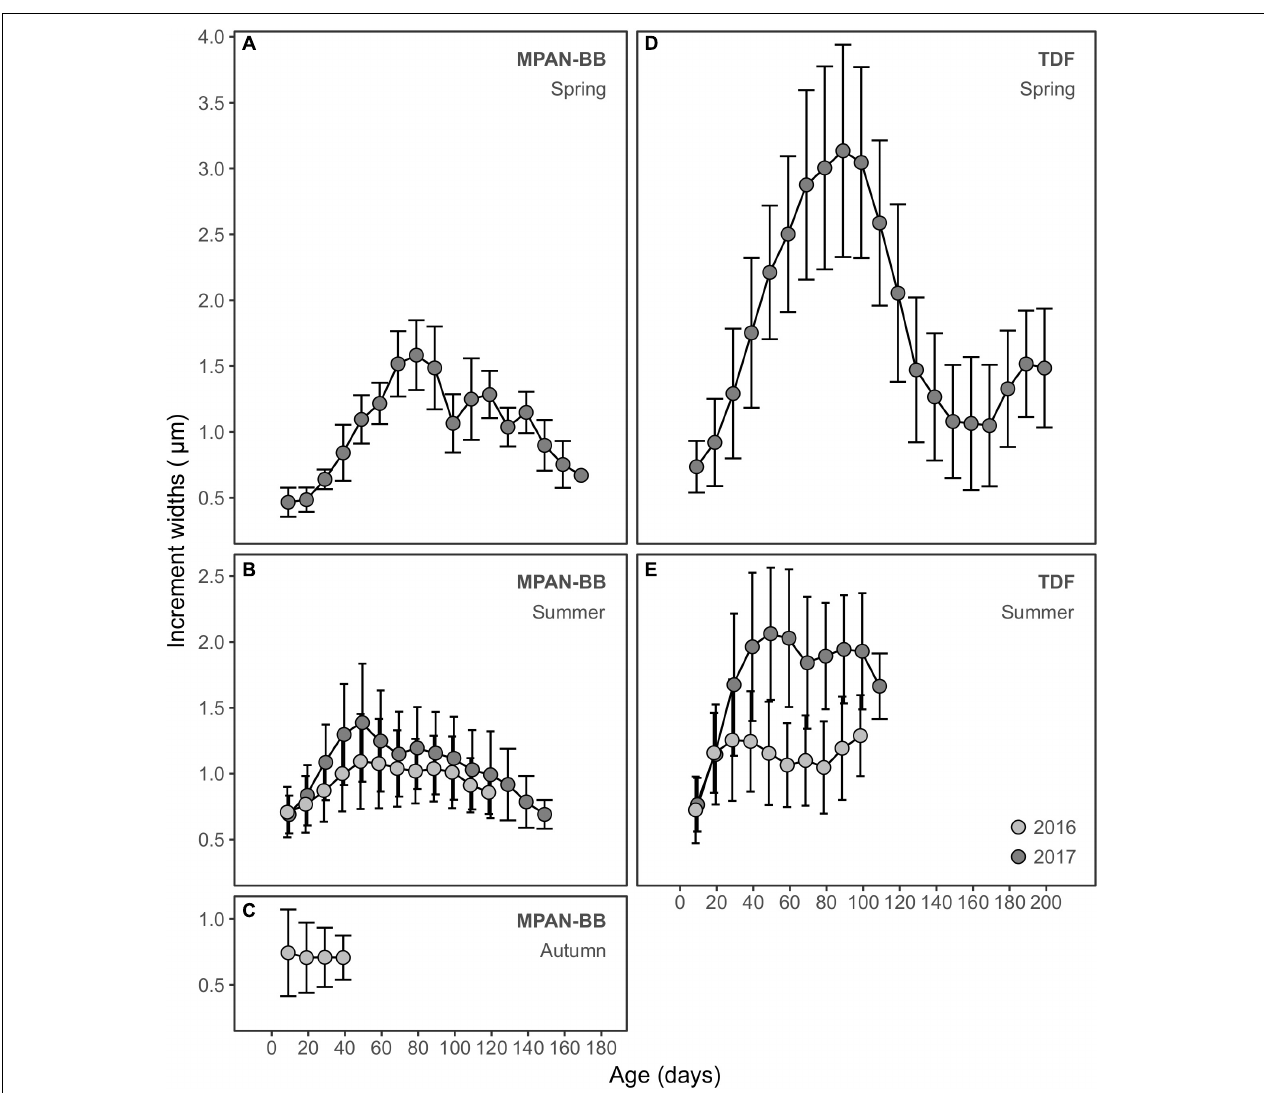
FIGURE 4 | Otolith increment widths ( µ m) in relation to age (days) of Fuegian sprat Sprattus fuegensis in the Marine Protected Area Namuncurá-Burdwood Bank (MPAN-BB) (A–C) and Tierra del Fuego (TDF) (D–E) . Records are grouped according to the year sampled (colors) and season of hatching: spring (A,D) , summer (B,E) and autumn (C) . Increment widths are averaged every 10 days, with variation around the mean displayed as standard deviations.